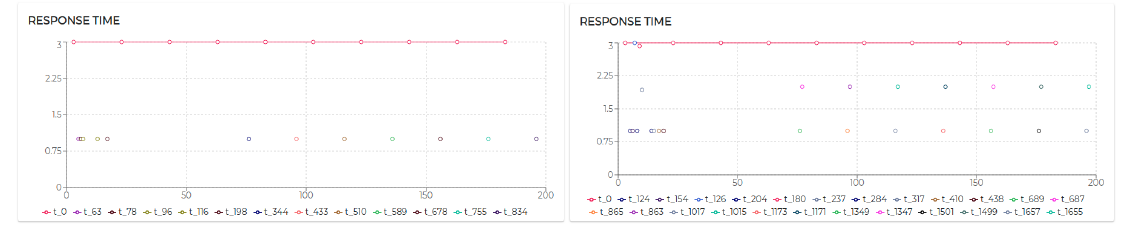
( a ) Response time of agent 0’s tasks in S1. Figure 14. Response times in scenarios S1 ( a) and S2 ( b ); y-axis: response time (seconds); x-axis: time